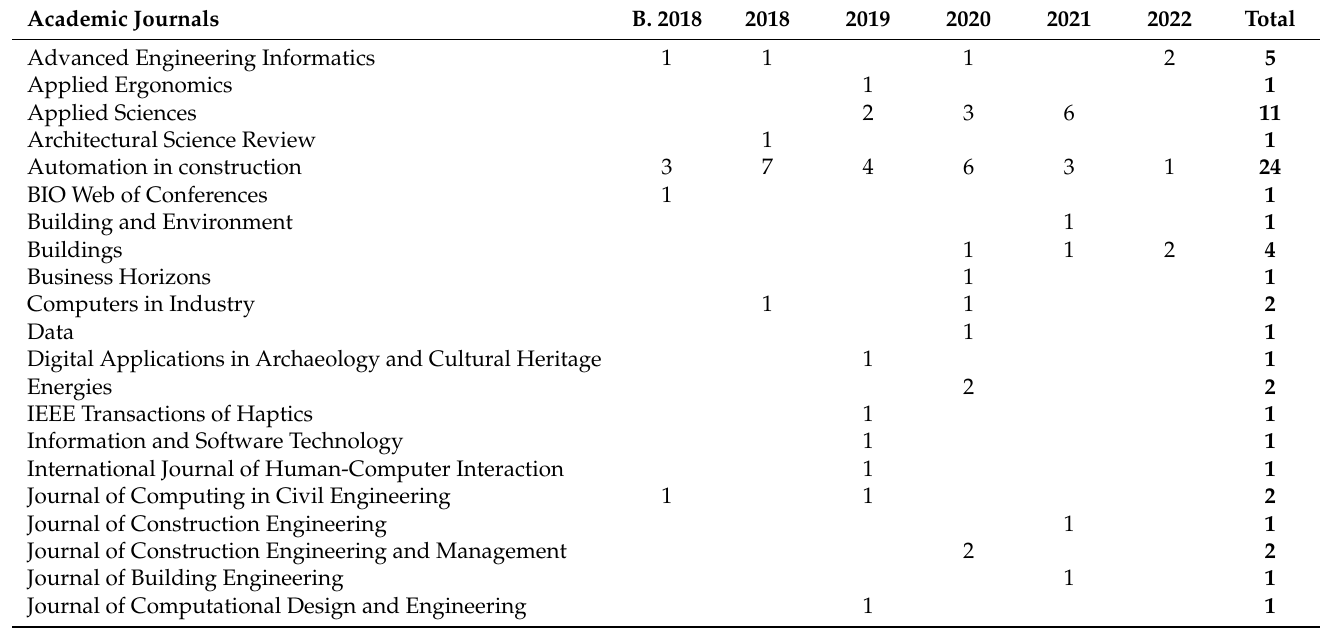
Table 2. Number of selected articles by journal and year of